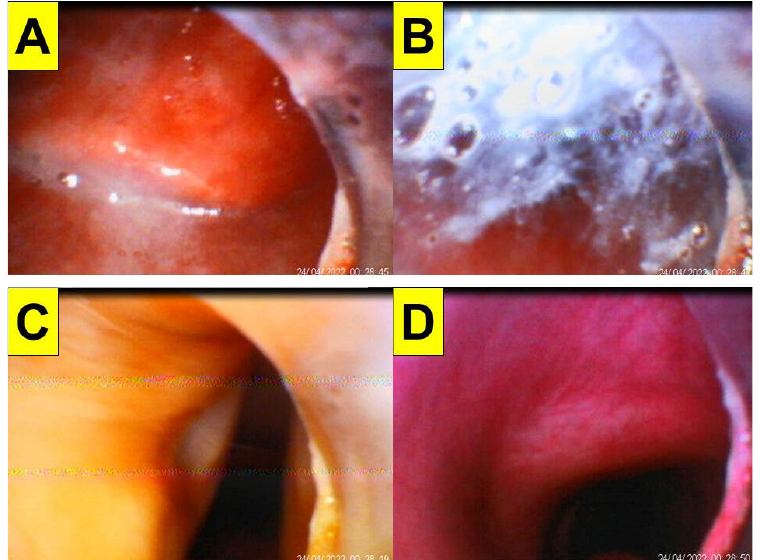
Figure 11. Tracheal intubation using the Shikani technique and plastic sheet barrier in a COVID-19 confirmed case for an emergency surgery. ( A ) Posteriorly displaced epiglottis; ( B ) obscured view by copious mucus; ( C ) full glottic view; ( D ) smooth insertion into tracheal lumen. The time for intubation (from lip to trachea) is 12 s (see also the video clip in the Supplementary Materials Video S5).